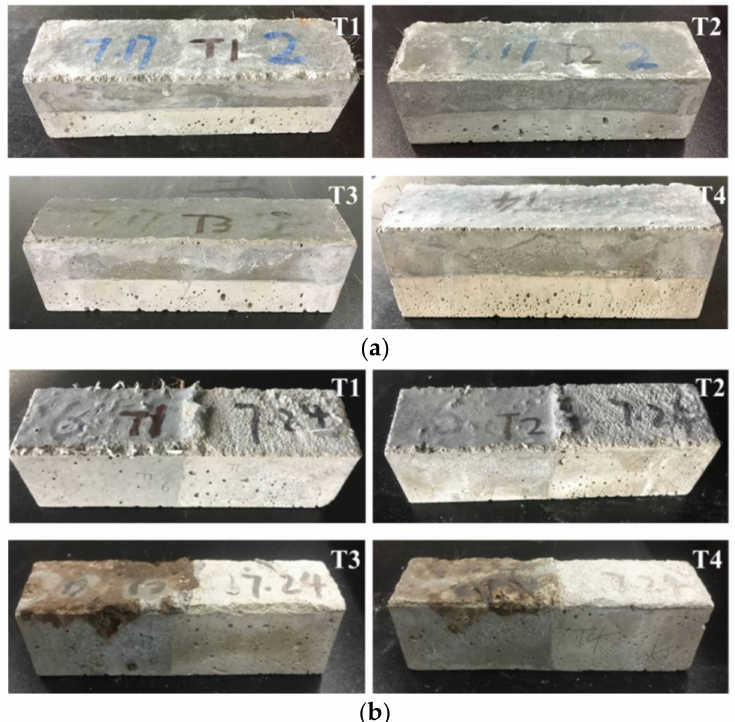
Figure 2. Appearance change of the repaired systems under different temperatures: ( a ) group 2 (Sf1), ( b ) group 4